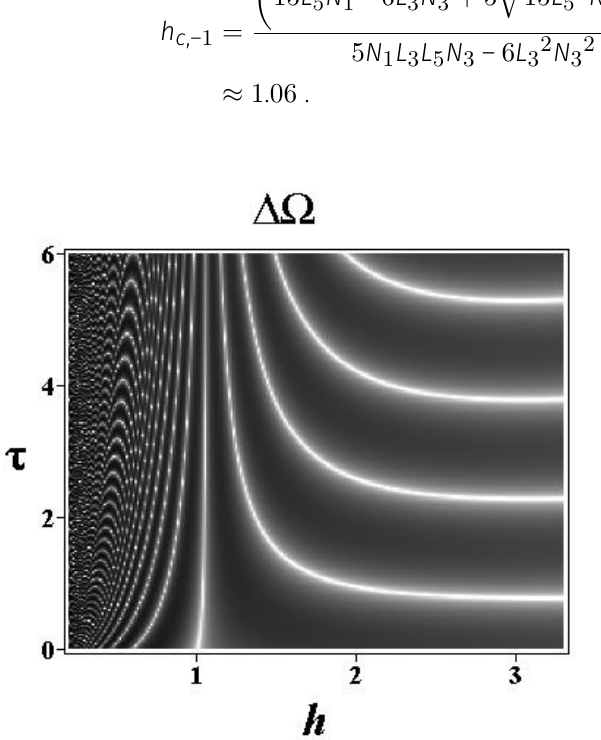
Figure 8. for the case where S = – 1 S = – 1 S = – 1 in Eqs. (65 and 66), shows in a grayscale map the temporal evolution of ∆Ω∆Ω∆Ω propagation at depths in the range h s ≤ h ≤ h d h s ≤ h ≤ h d h s ≤ h ≤ h d . Since in this figure the brightest tones represent intense amplitudes, it can be observed that around depths h = h c ,– 1 h = h c ,– 1 h = h c ,– 1 (see Eq. 67) a barrier of high wave amplitudes is established, moreover it can also be observed that the pattern of these intense peaks are quite different in shallow waters from those in deeper